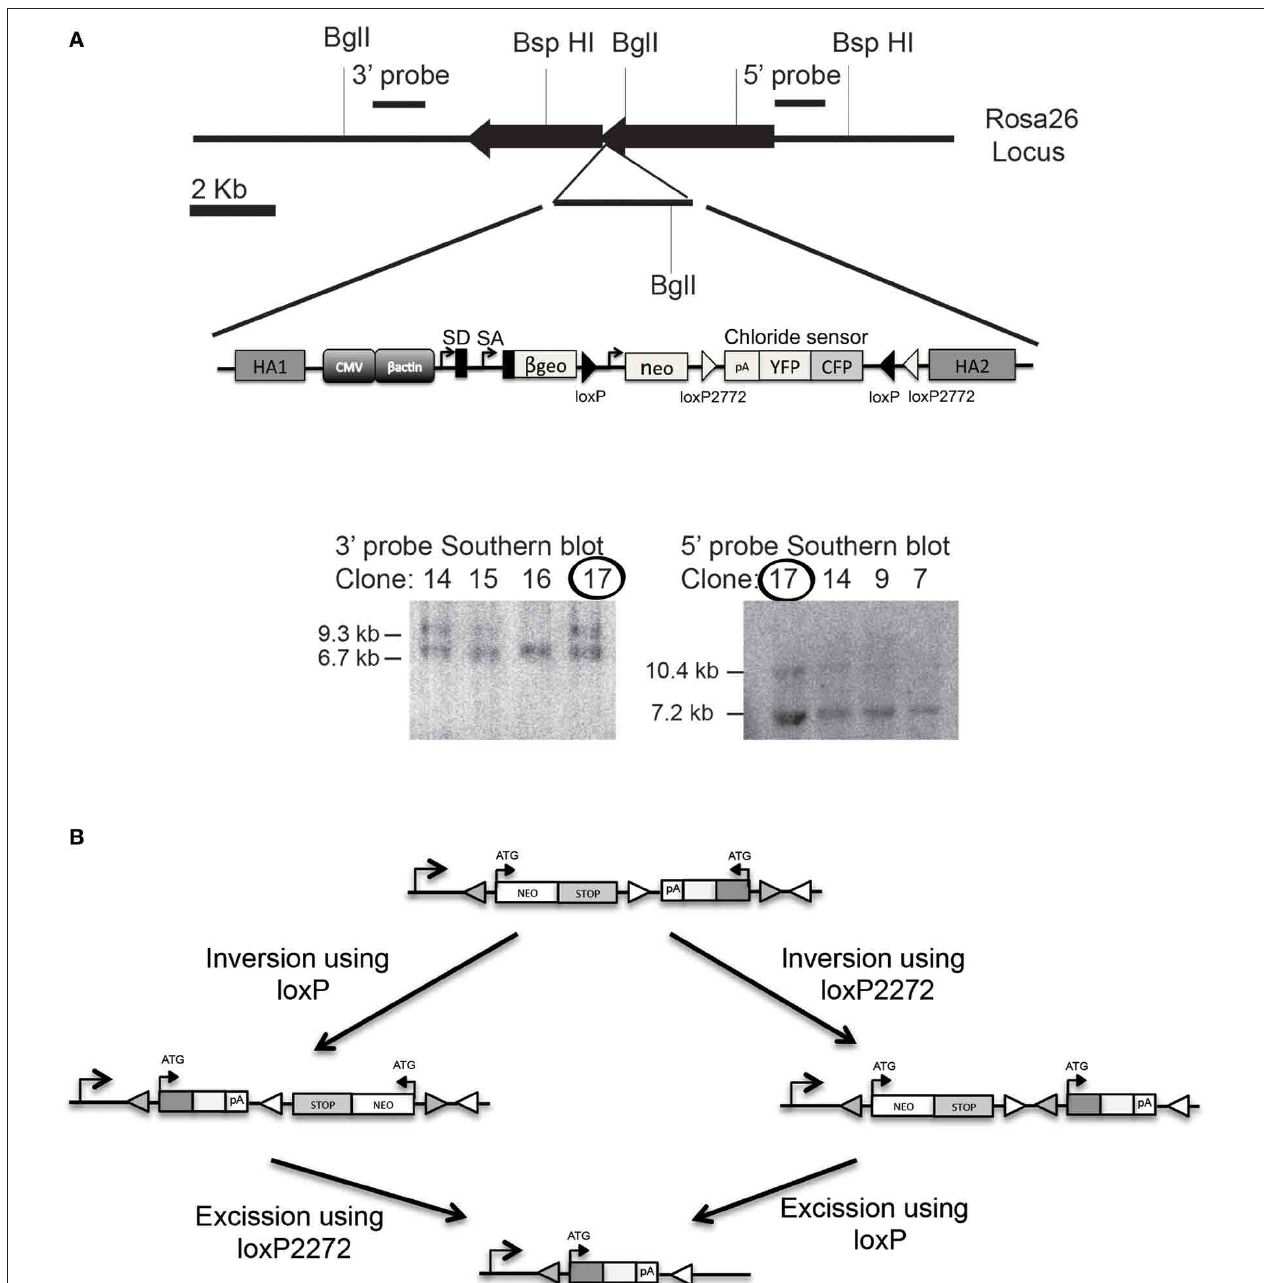
FIGURE 3 | Generation of Cl-Sensor transgenic mouse. (A) The Cl-Sensor cassettes were assembled and inserted into the XbaI site of the ROSA26 targeting vector. Southern blot was used to confirm proper homologous recombination on ES cell selected clones. Clone number 17 was selected for blastocyst injection. (B) Schematic representation of the Rosa26 locus after